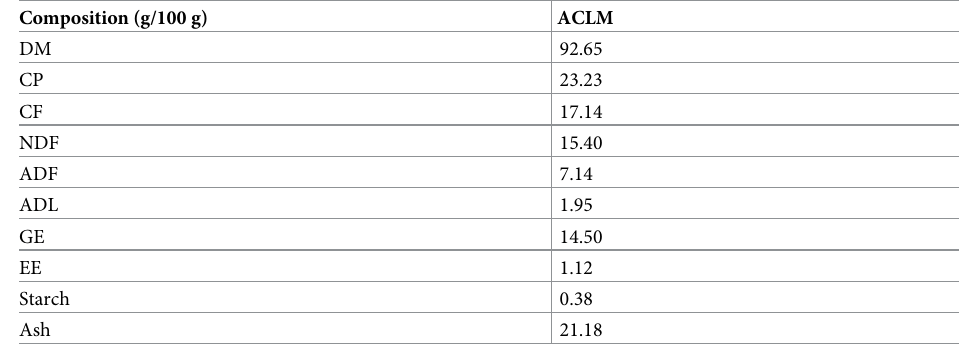
Table 1. Proximate composition (g/100 g), gross energy (kcal/g) of Amaranthus cruentus leaf meal